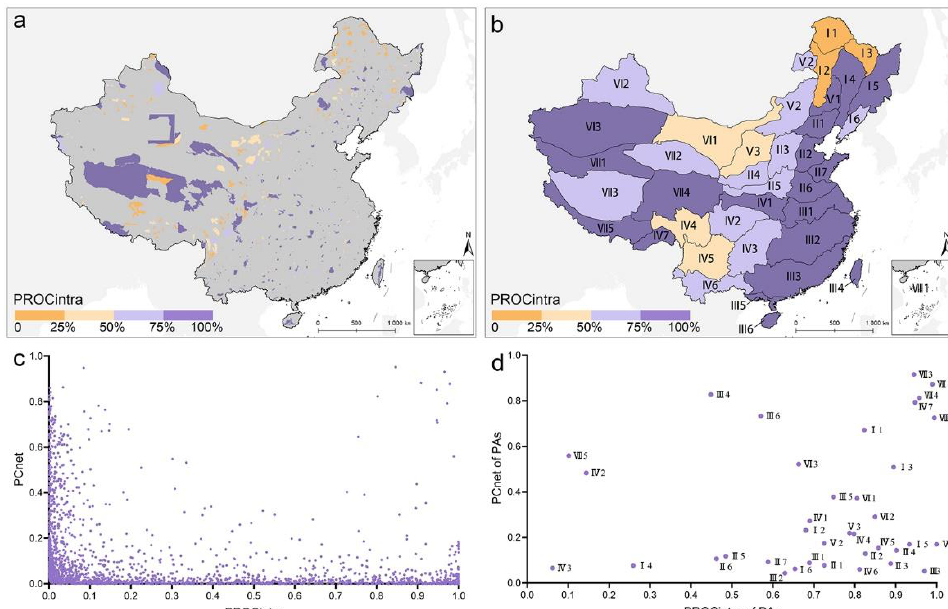
Figure 5. ( a ) The proportion of network connectivity of protected area (PA) patches provided by intra-patch connectivity in China based on PROCintra indicator. ( b ) The proportion of network connectivity of ecological zones’ PA network provided by intra-patch connectivity in China based on PROCintra indicator. ( c ) Relationship between PCnet and PROCintra of PA patches in China. ( d ) Relationship between PCnet and PROCintra of ecological zones’ PA network in China.